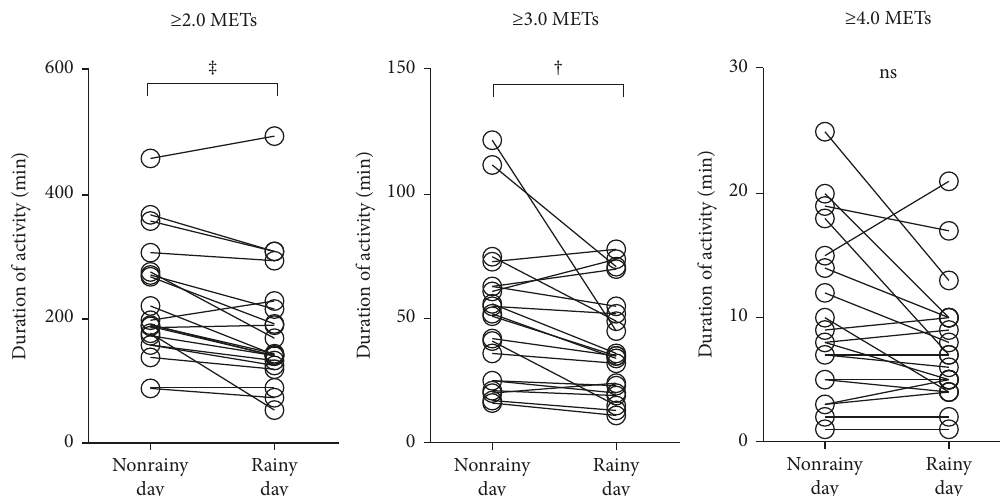
Figure 2: Effect of rainy days on the duration of PA. METs: metabolic equivalents; PA: physical activity; ‡: p < 0 . 001; †: p < 0 .